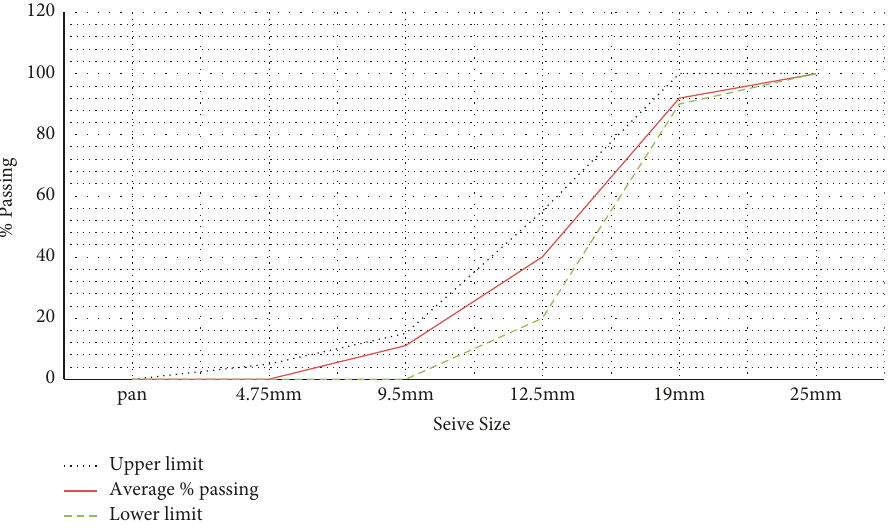
Figure 3: Coarse aggregate particle size distribution. Table 3: Physical properties of course aggregate.